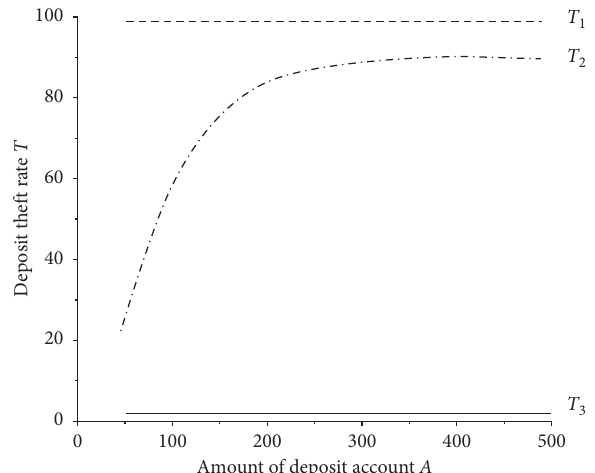
Figure 7: Operational deposit theft rate of the shared bicycle deposit management